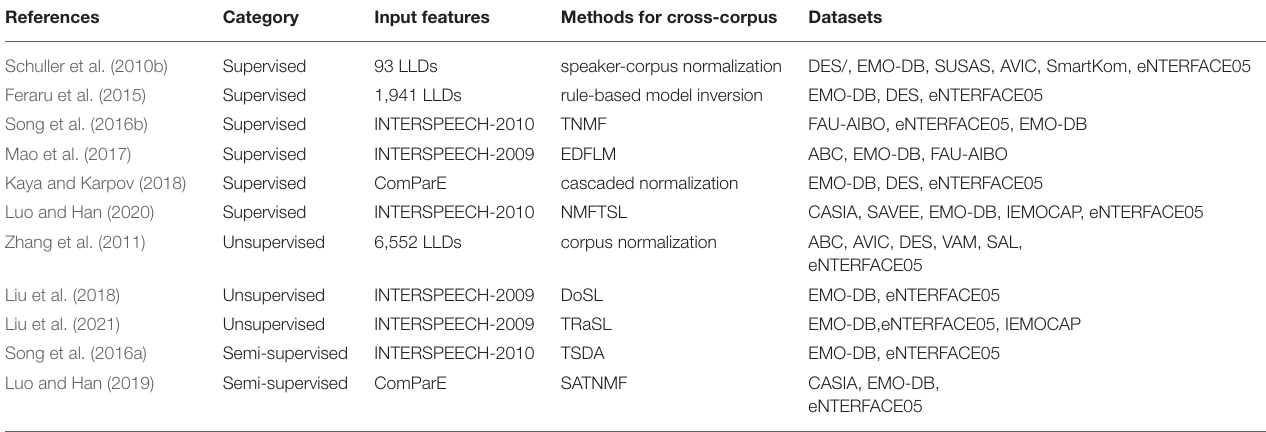
TABLE 2 | A brief summary of traditional cross-corpus SER